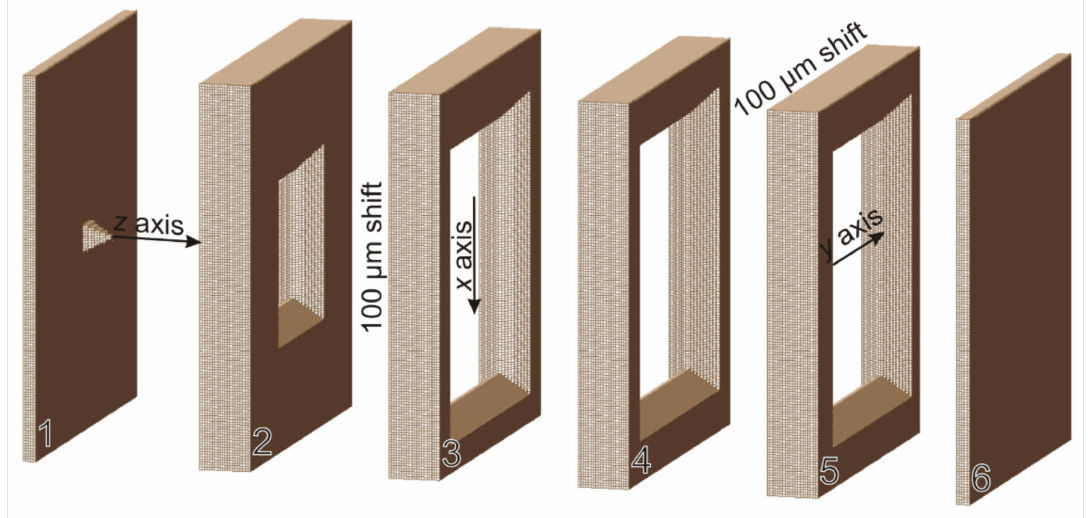
Figure 14. Scheme of the non-axial microcolumn.